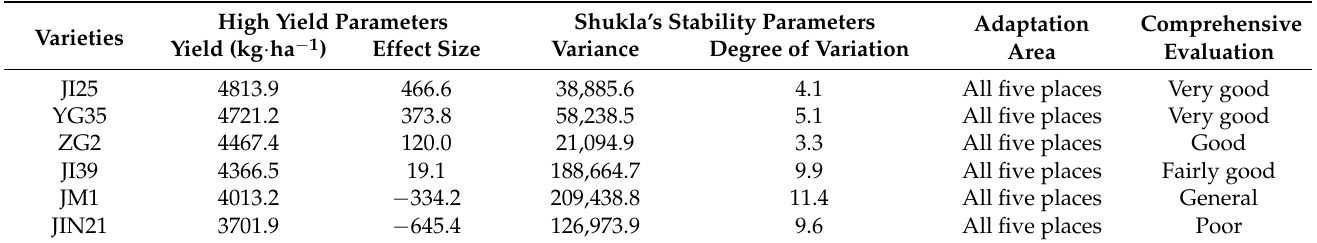
Table 7. Analysis of high yield and stability of